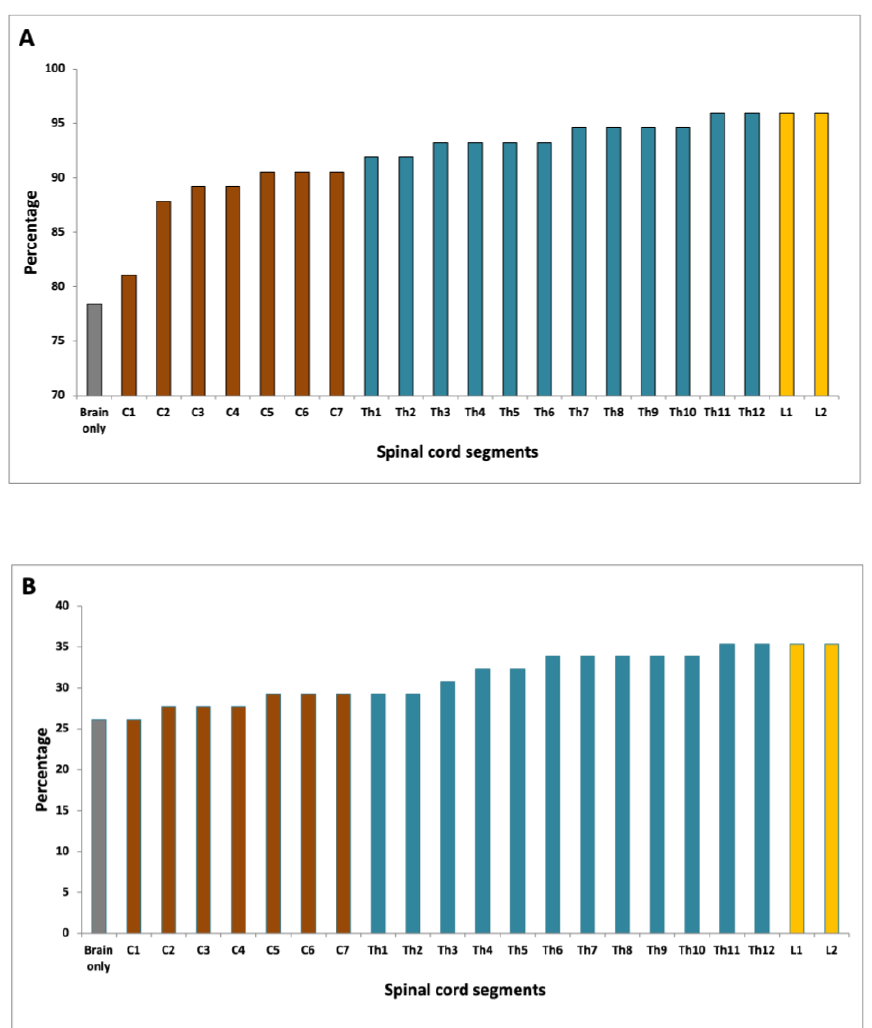
Figure 4. ( A ) Fulfillment of DIS according to the spinal cord level evaluated; ( B ) Fulfilment of DIT according to the spinal cord level evaluated.